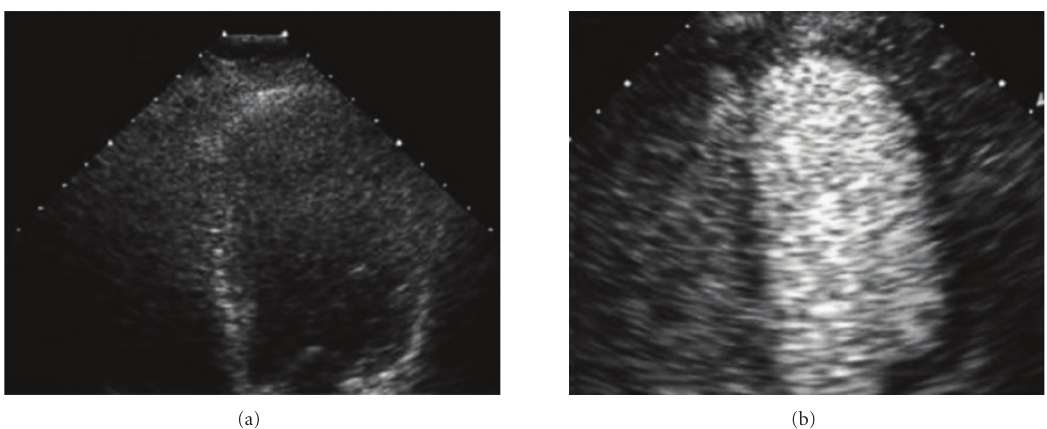
Figure 1: (a) Apical 4-chamber view (left ventricle on right, end-diastole) with harmonic imaging. (b) Same view with enhancement due to intravenous microbubble contrast agent. Image shows marked improvement of endocardial border definition, especially at apex and in mid segment of anterolateral